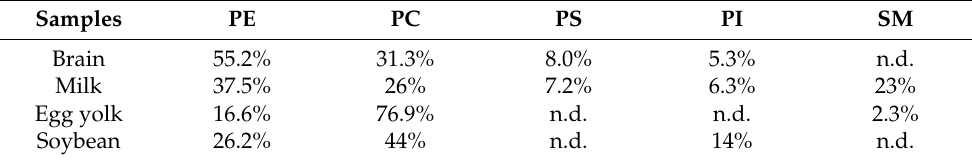
Table 1. Brain distribution of phospholipids per mg of tissue and distribution of phospholipids in the main dietary sources expressed as percentage (%) of total phospholipids. Modified from [74] with permission from Elsevier. Furthermore, a small portion of data from [75] are included.